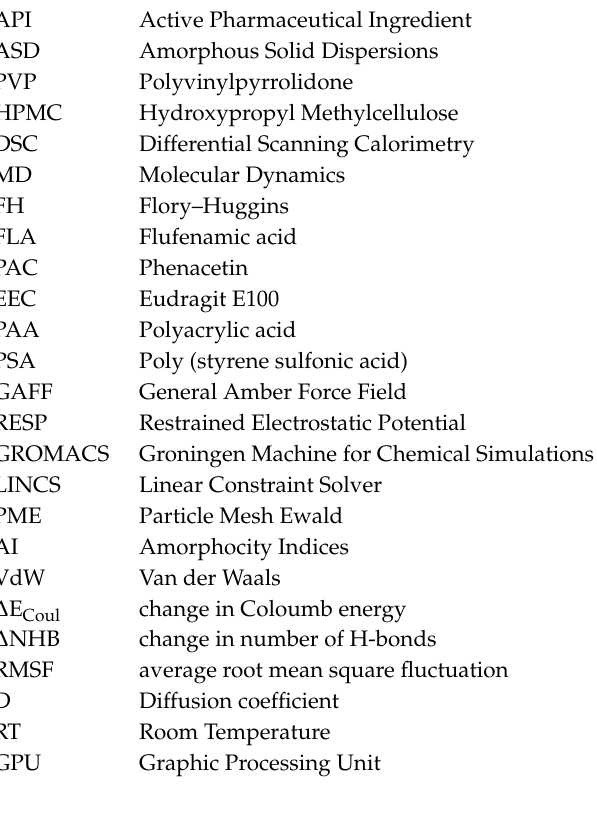
Figure S1: Literature data for eight different API molecules. Figures S2–S15: Convergence of various quantities calculated in MD